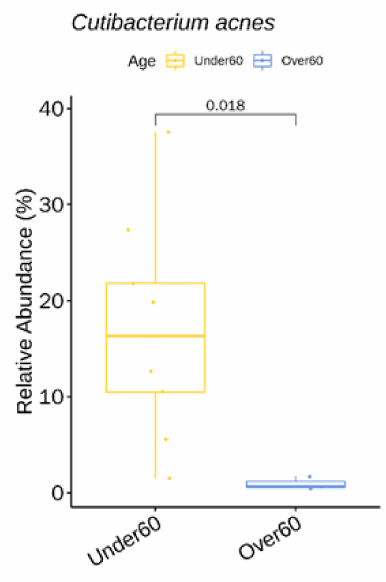
Figure 5. C. acnes showing a significantly higher relative abundance in the 60 & Under-age group at baseline.